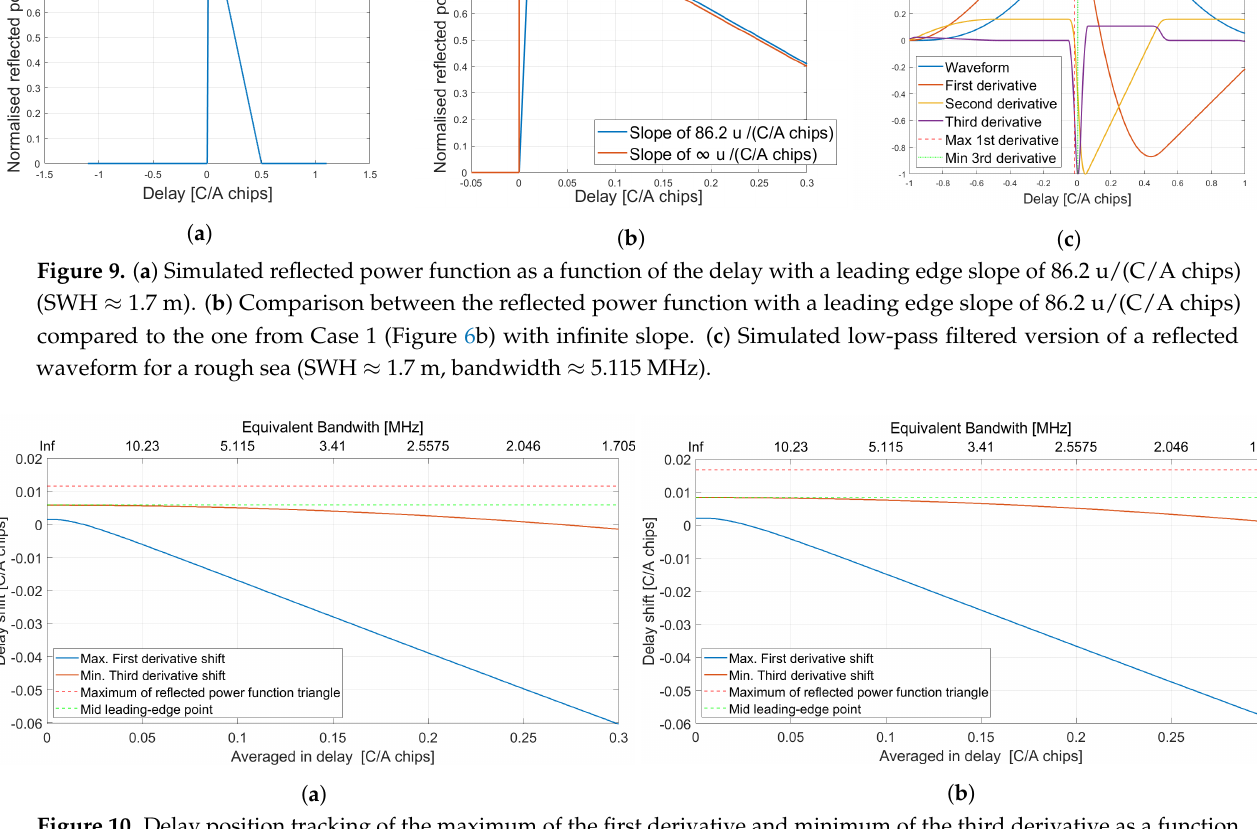
Figure 10. Delay position tracking of the maximum of the first derivative and minimum of the third derivative as a function of the bandwidth (considering leading-edge of ( a ) slope 86.2 u/(C/A chips), SWH ≈ 1.7 m and ( b ) a slope 60 u/(C/A chips), SWH ≈ 2.4 m ). The minimum of the third derivative tracks the mid-rise position of the leading-edge of the reflected power function (marked with a dashed green line, while the maximum of the triangle is marked with a dashed red line). The maximum of the first derivative tracks a point near the zero delay for very large bandwidths, and then it starts to